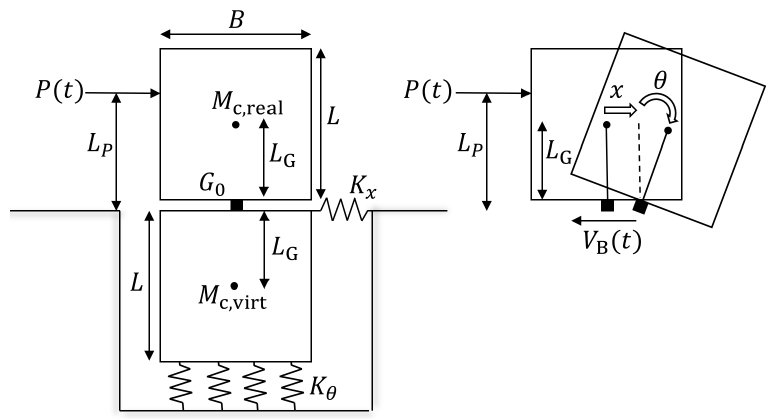
Figure 10. Analytic dynamic model of caisson breakwater as proposed by Goda